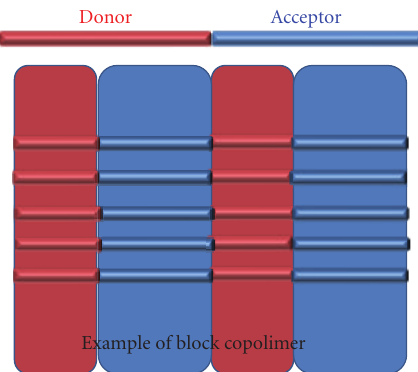
Figure 4: Schematic representation of block copolimer as an OPV device.